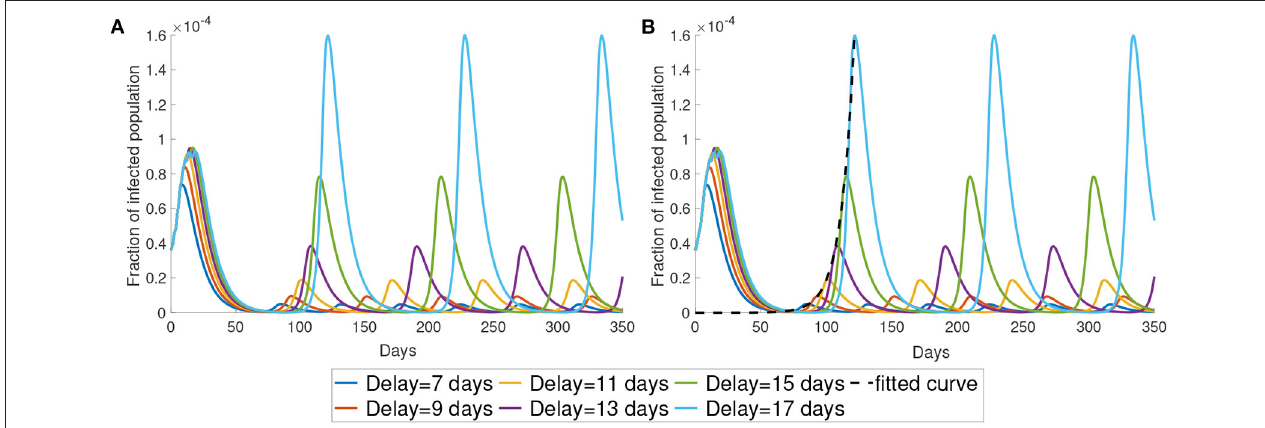
FIGURE 4 | The impact of time delay. (A) We present the simulation with different delays. (B) We use exponential curve to fit the maximum in the first wave of the simulation. The fitted exponential curves are the black dotted